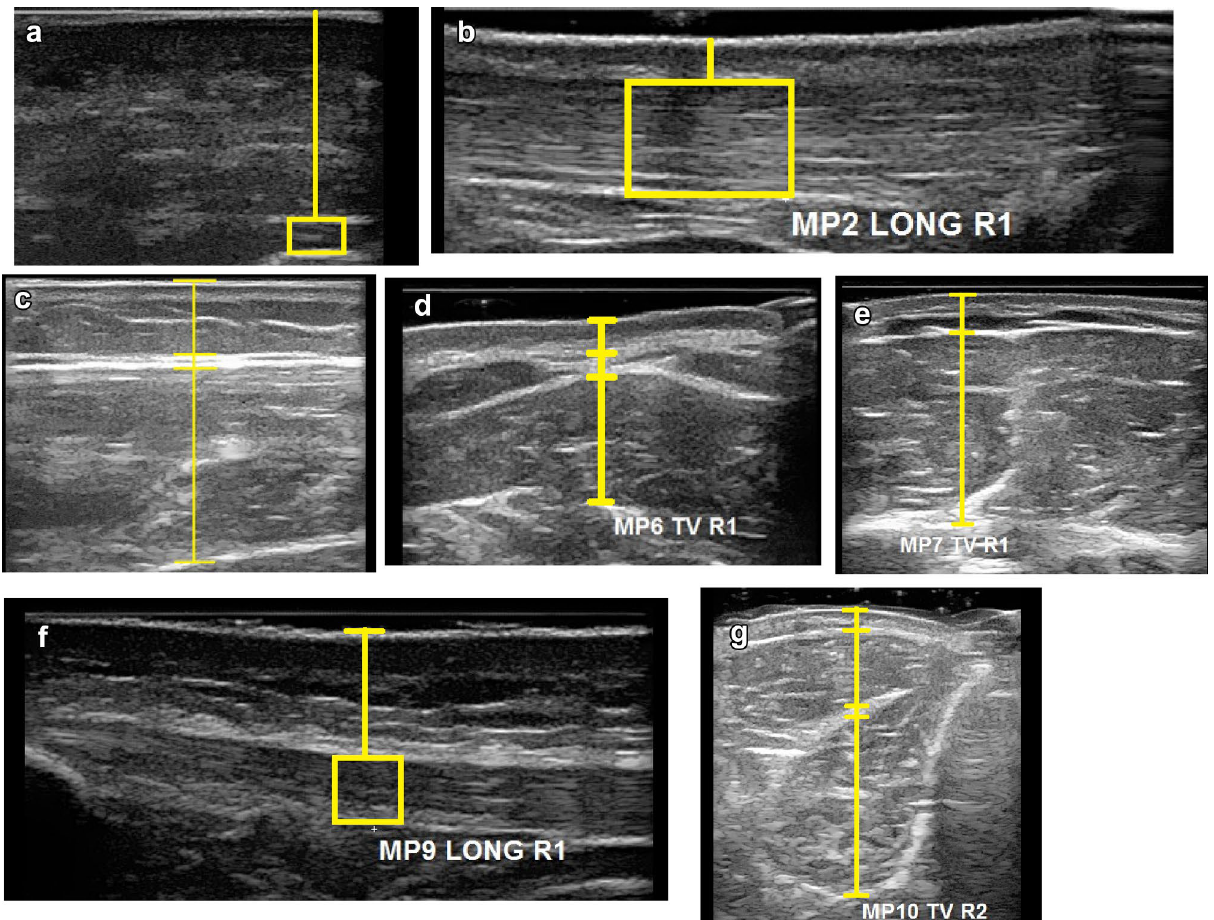
Figure 2. Example of ultrasound, and measurement points for data analysis. ( a ) Plantar Fascia, ( b ) Achilles tendon, ( c ) Soleus, ( d ) Splenius capitis, ( e ) Anterior Deltoid, ( f ) Patellar tendon, ( g ) Anterior scale displayed on the side of the ultrasound image. The GUI then allowed measurements to be made on the ultrasound image by the investigator through identifying and clicking on various landmarks. Specific landmarks and measurements are detailed below for each muscle and tendon. Distances were then calculated as the Euclid- ean distance between landmarks, then converting to centimetres using the scaling factor and then exported to an Excel file. Scans were calibrated against the scale on the side of the ultrasound scan, marking a measurement of 1 cm with a cursor. Passive muscle thickness was measured on cross-section planes of ultrasound scans between the muscle’s borders from the bottom of their superior fascia to the top of the inferior fascia. Tendon/fascia thickness was measured by creating a 1 cm wide box, then creating a line on the top of the structure and a line at bottom. The distance between the two lines was then automatically measured 100 times and the mean thickness measurement was taken. Subcutaneous tissue thickness was measured from the top of the skin to the superior border of the muscle fascia (that is regular peripheral body fascia structure with compartment fascia and epimysial layers considered as one structural layer (i.e., muscle fascia) of regional variance however all these structural layers are however below USI image resolution). A second measurement was taken from the superior border of the muscle fascia to its infe- rior border. The thickness of the fascia was included with fat thickness in the subcutaneous tissue measurement (Fig. 2). The deep foot extensors (MP10 deep foot extensors)- only measured with ultrasound using the same subcutaneous tissue thickness as MP10, but with the muscles measured as one complex all the way to the tibia. Minimal detectable change (MDC).